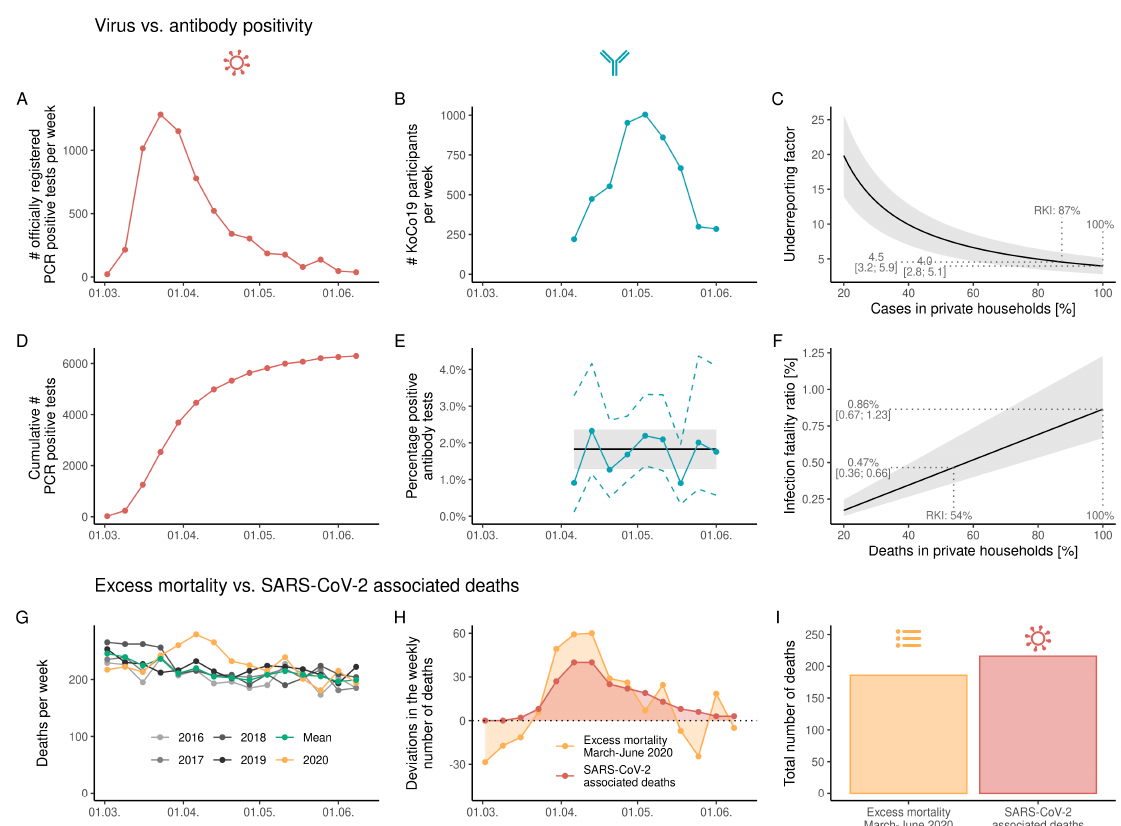
Figure 3. Dynamics of the COVID-19 pandemic and of the KoCo19 study in Munich since the beginning of the pandemic to the end of the KoCo19 study period. ( A ) Official weekly absolute number of newly diagnosed COVID-19 cases based on positive PCR tests. ( B ) Weekly number of participants recruited to the KoCo19 study. ( C ) Estimated underreporting factor depending on the percentage of reported cases in private households with respect to all reported cases in Munich. ( D ) Cumulative weekly number of officially registered COVID-19 infections in Munich. ( E ) Numbers of Elecsys Anti-SARS-CoV-2 Roche anti-N pan-Ig (Ro-N-Ig) seropositive samples per week (blue) divided by the number of blood draws in the respective time frame. 95% CIs (blue dashed lines) are based on an approximate Poisson assumption. Black line and shaded area indicate the weighted and adjusted prevalence estimate with 95% CI. Due to low recruitment numbers in the last week, in ( D , E ), the data from the last week were integrated with the pre-last week. ( F ) Estimated infection fatality ratio depending on the percentage of reported COVID-19-related deaths in private households with respect to all reported COVID-19-related deaths in Munich. ( G ) Weekly number of deaths in Munich for 2016–2020 in terms of official numbers. ( H ) Weekly excess mortality in 2020 compared to 2016–2019 in terms of official death counts and official SARS-CoV-2-related deaths. ( I ) Comparison of total number of deaths in terms of excess mortality and registered SARS-CoV-2-related deaths.